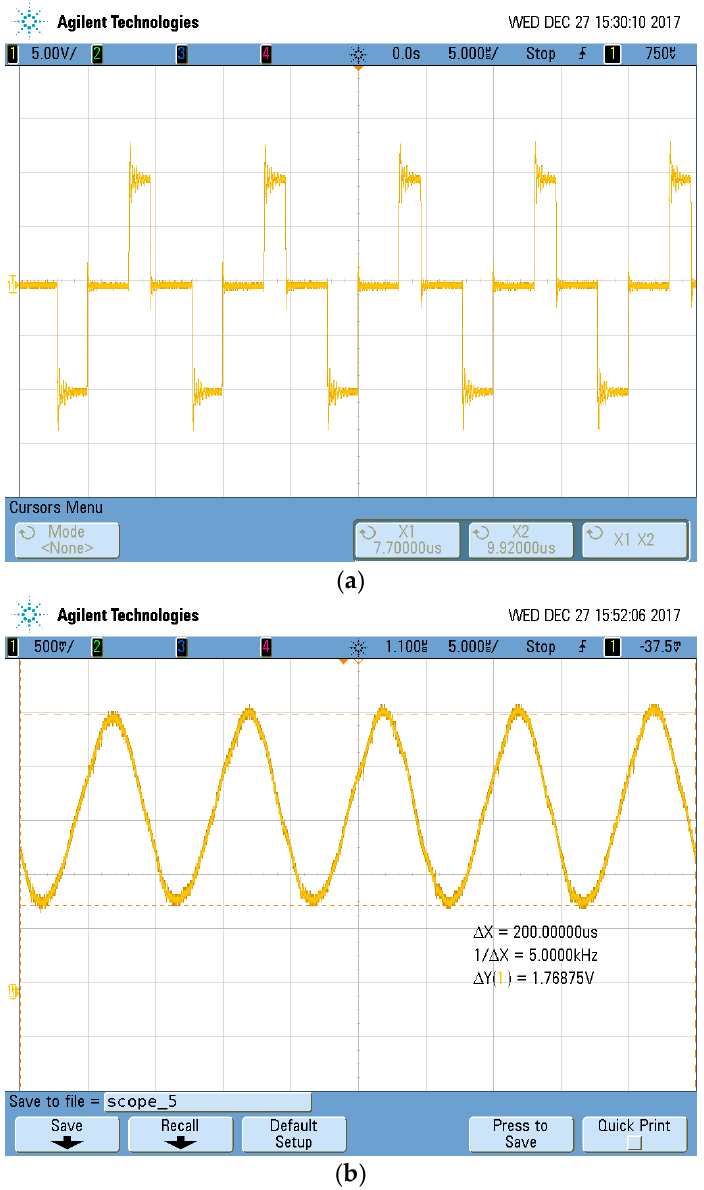
Figure 11. Input voltage and input current of the coupling compensation circuit in the experiment: ( a ) output voltage of the full-bridge inverter, and ( b ) measured value U M of I P .